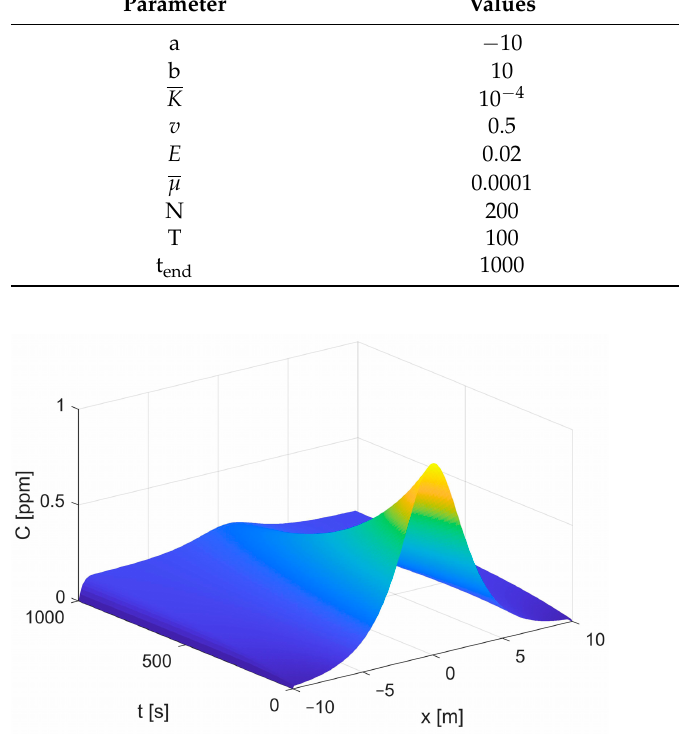
Table 2. Material parameters for FD radionuclides transport.